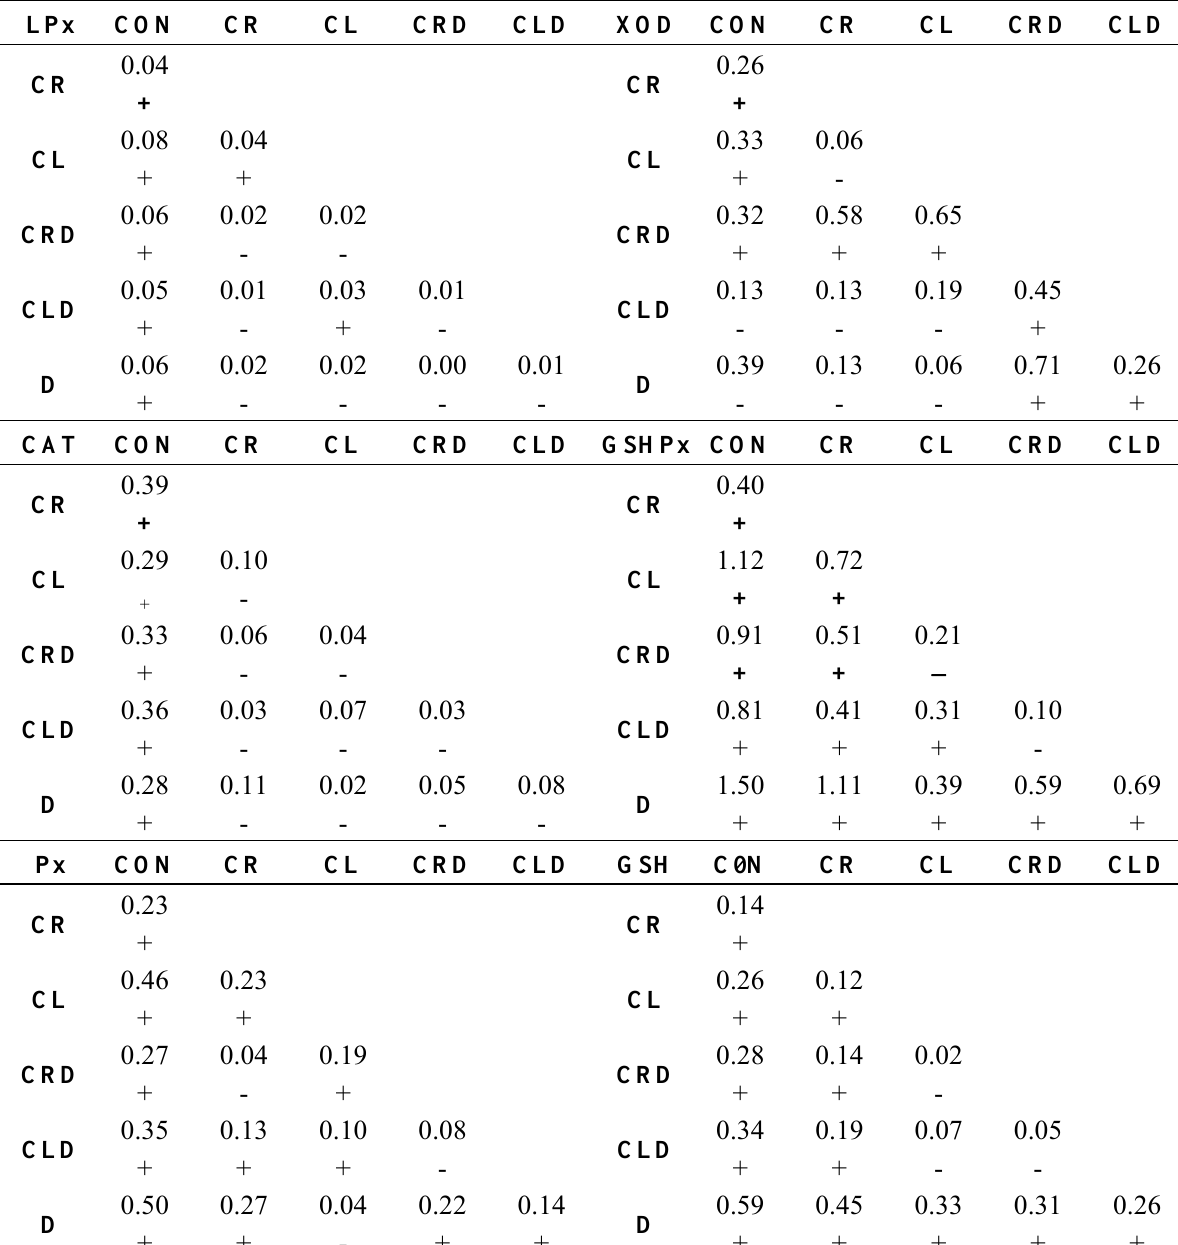
Table 4. ANOVA Test for Biochemical Parameters Measured in Blood